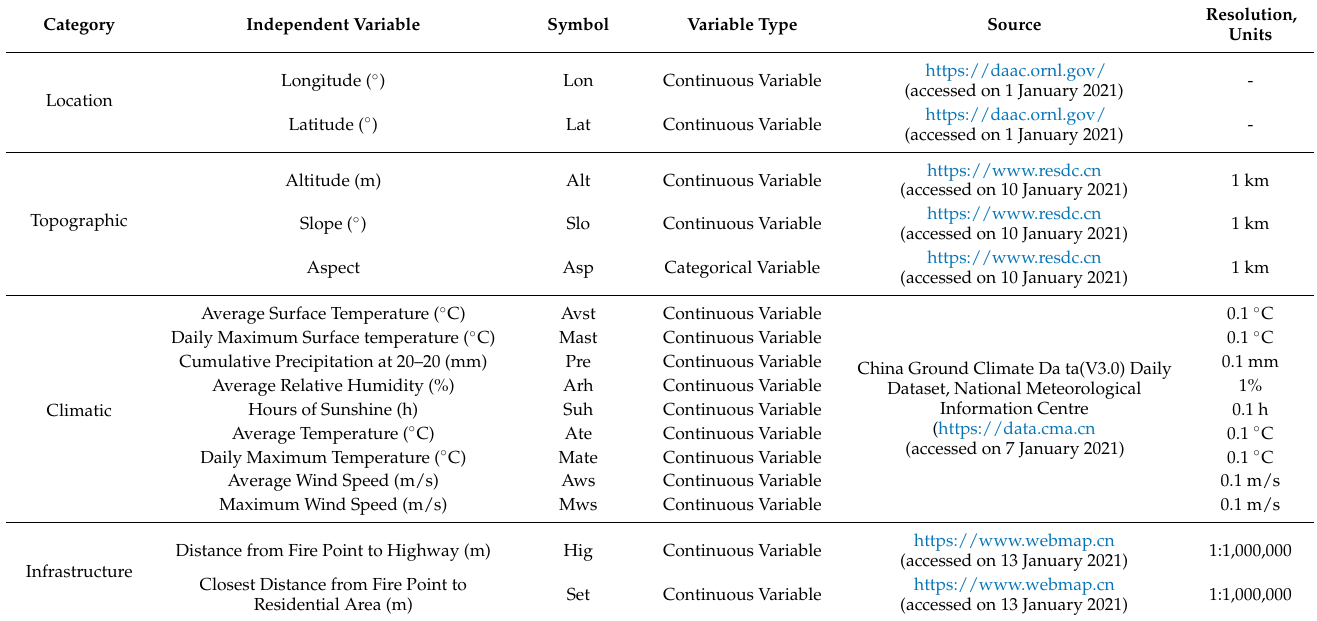
Table 2. Descriptions of independent